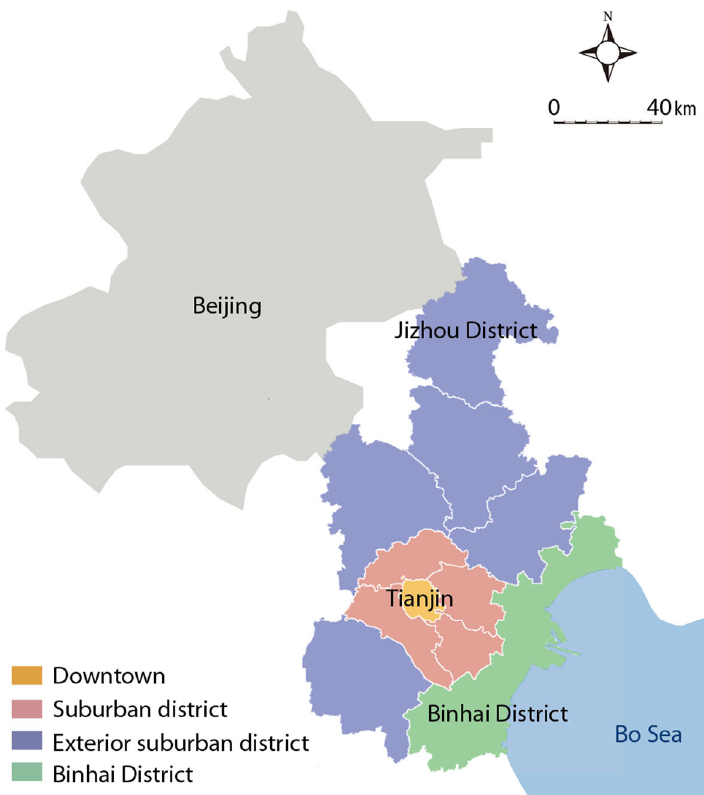
Fig. 2 Map of Tianjin and Beijing (Source: Yue Lu,